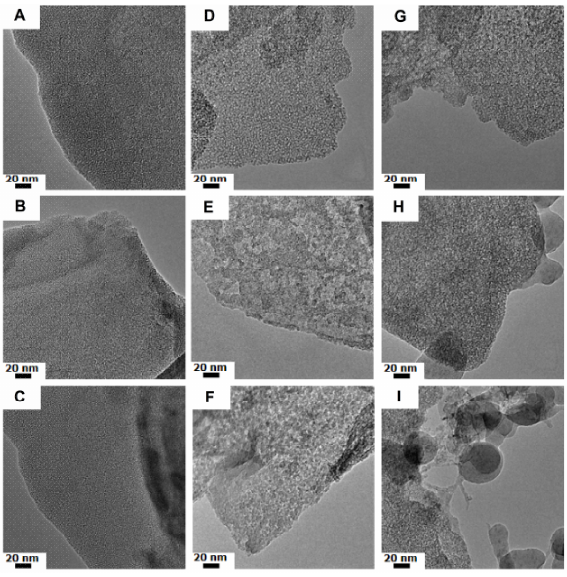
Figure 7. Transmission electron microscopy image of mSiO 2 after GO immersed in water ( A – C ), the PBS solution ( D – F ) and medium ( G – I ) for 24 h (images A , D , G ), 48 h ( B , E , H ), and 72 h ( C , F , I ).